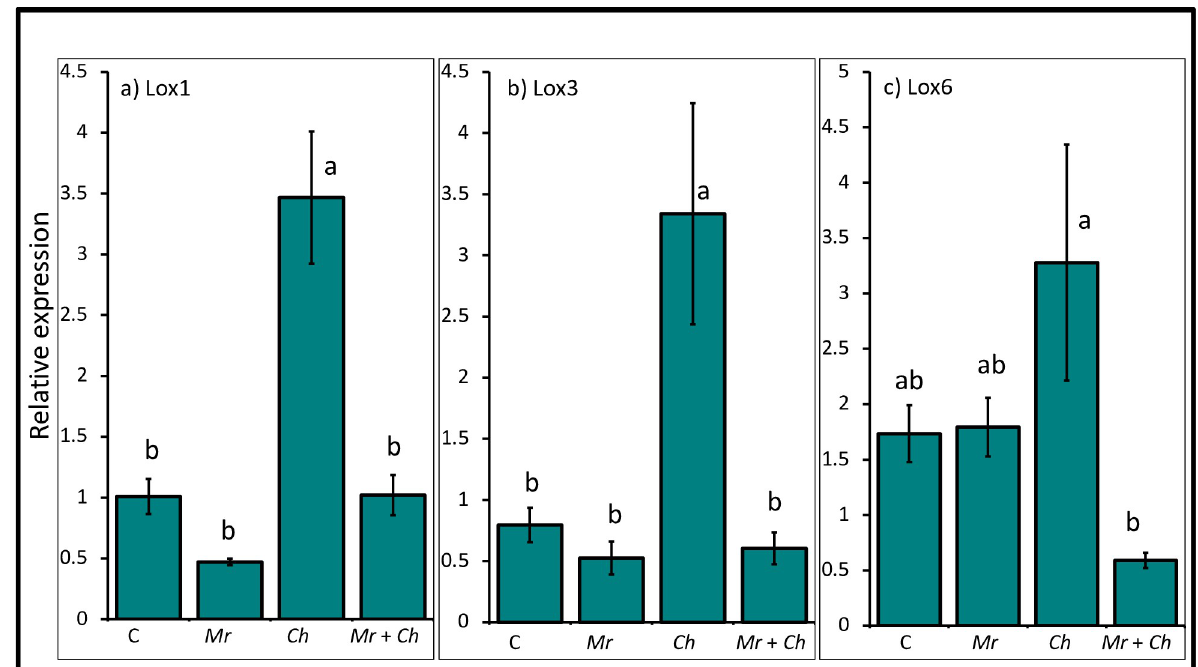
Fig 4. Relative expression of lipoxygenases genes. Mean relative expression of genes belonging to the JA pathway (a) lipoxygenase 1 ( lox1 ) ( F 3,43 = 24; P < 0.0001), (b) lipoxygenase 3 ( lox3 ) ( F 3,43 = 8.6; P < 0.0001), (c) lipoxygenase 6 ( lox6 ) ( F 3,43 = 3.8; P = 0.02) from 4 th true leaf of V4 maize in the M . robertsii (Mr), C . heterostrophus (Ch), M . robertsii + C . heterostrophus (Mr + Ch) treatments and untreated control (C). Values are untransformed means ± SEM; different letters indicate significant differences at α = 0.05.